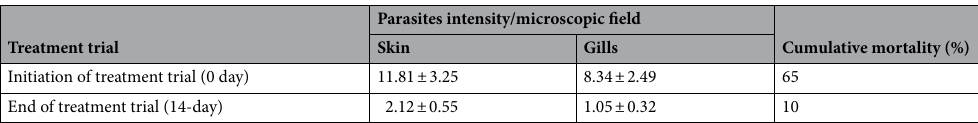
Parasites intensity/microscopic field